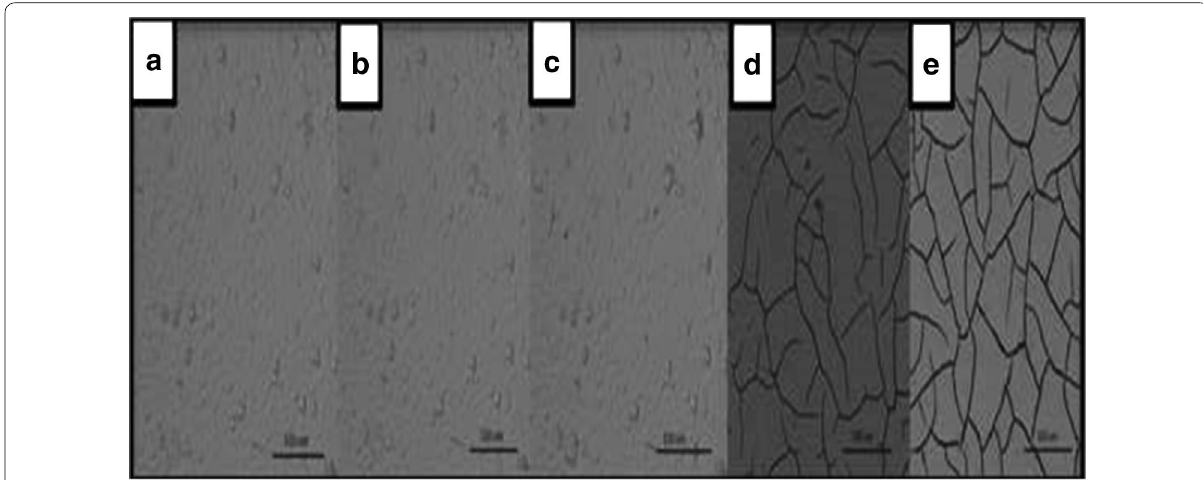
Fig. 3 SEM images of a one layer, b two layers, c three layers, d four layers and e five TiO 2 layers coated on FTO glass by screen‑printing technique, respectively